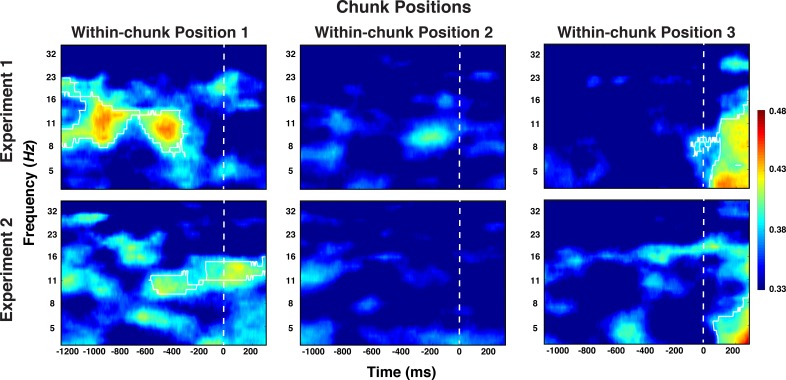
Experiment 1 and 2 decoding results as a function of frequency and time for chunk position, shown separately for the within-chunk positions 1, 2, and 3.The legend shows the decoding accuracy in probability. Chance level is p = 0.33. The regions enclosed by white lines show significant decoding accuracy after cluster correction.